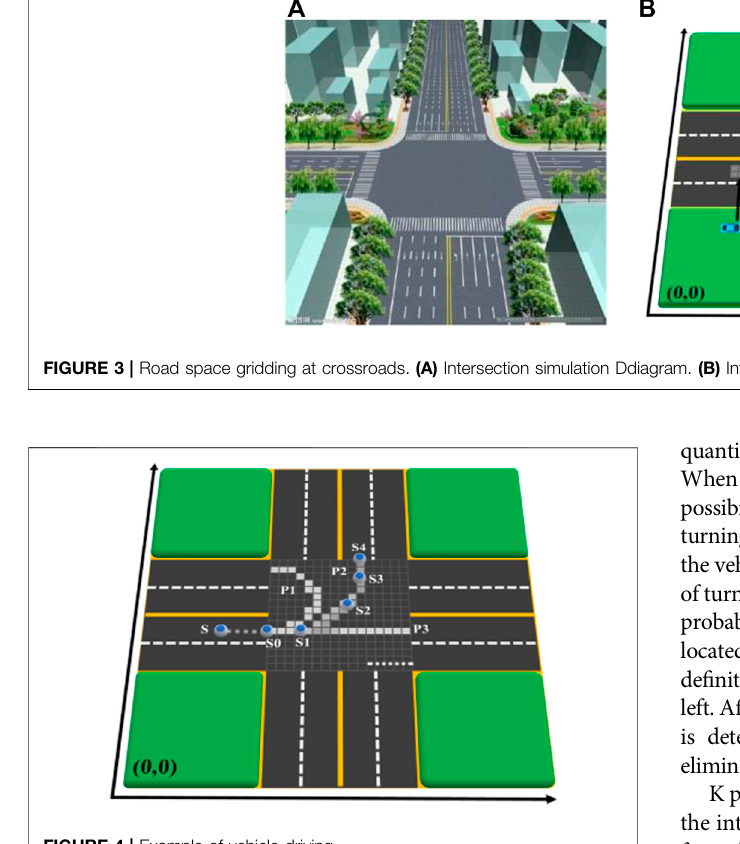
FIGURE 4 | Example of vehicle